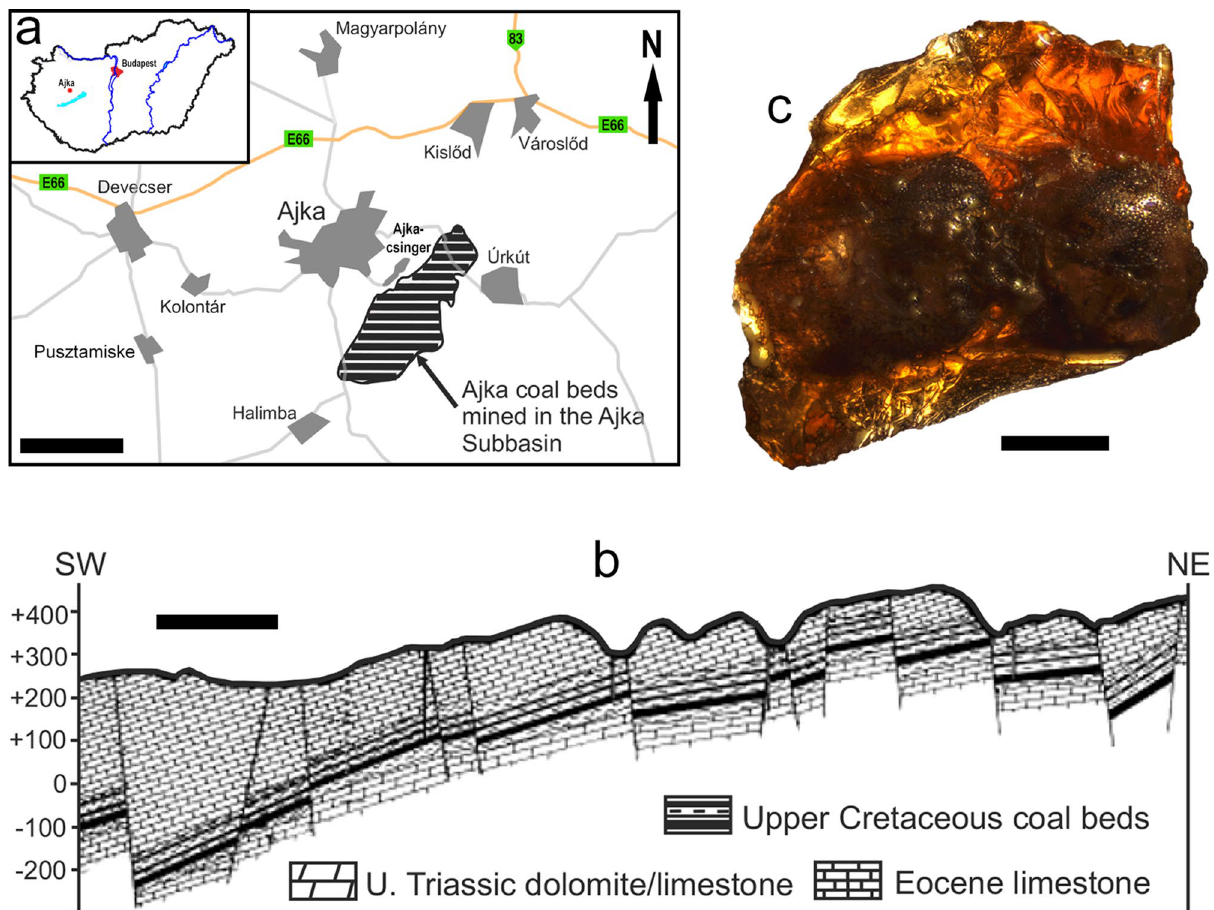
Figure 1. Ajka location and geology, and the here examined amber inclusion. ( a ) Location of Ajka in western Hungary, with the location of the Ajka coal beds. ( b ) Simplified geological section of the Ajka Subbasin. ( c ) Ajkaite specimen containing the holotype of Ajkaelater merkli gen. et sp. nov., under polarized light microscope. Scale bars: ( a ) 3 km; ( b ) 1 km; ( c ) 1